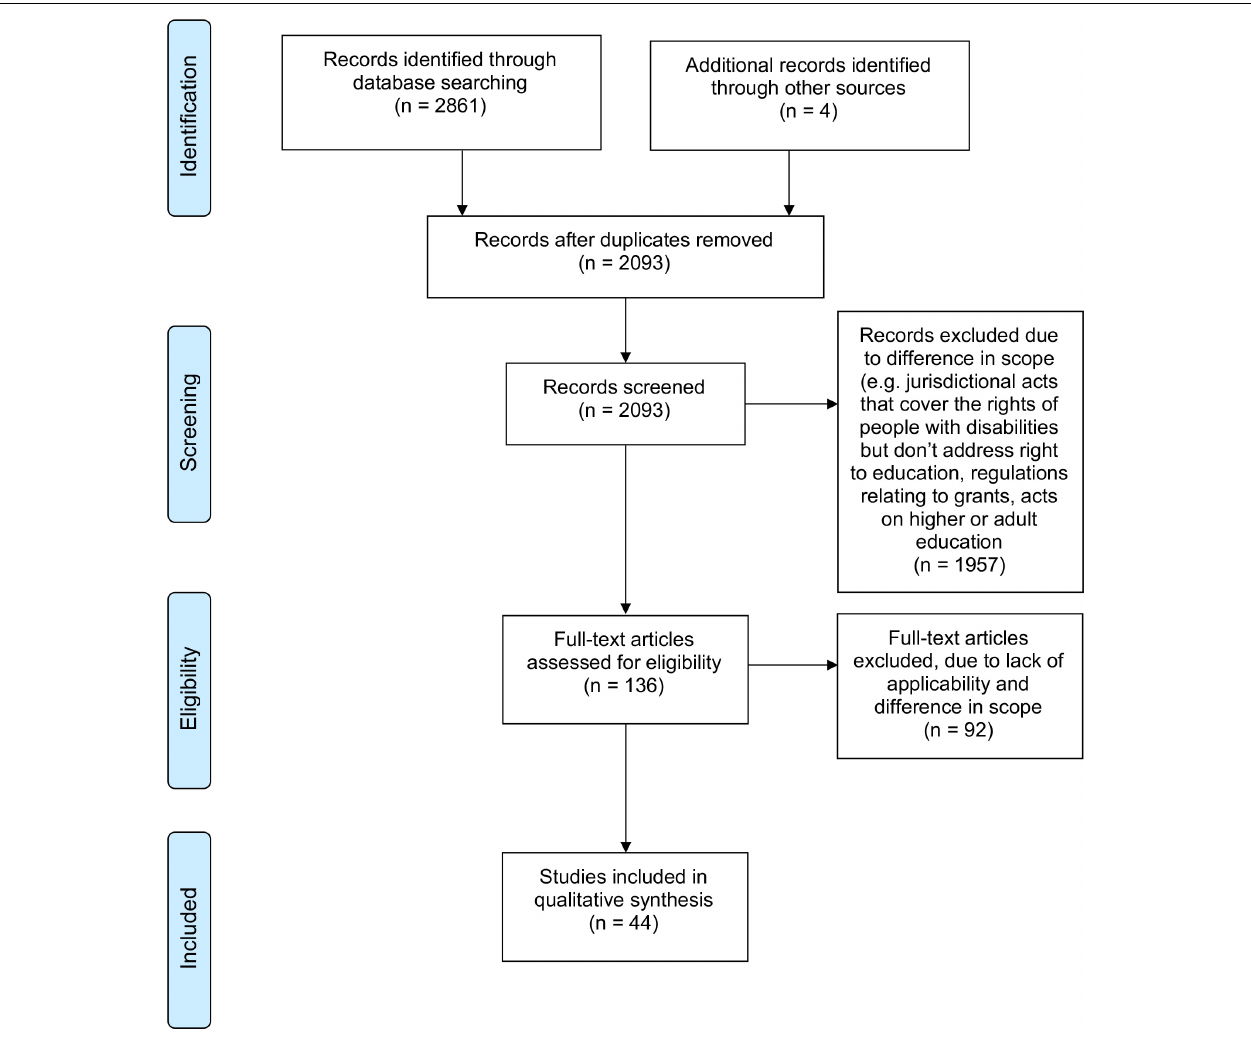
FIGURE 1 | The PRISMA flowchart depicting the data collection process.